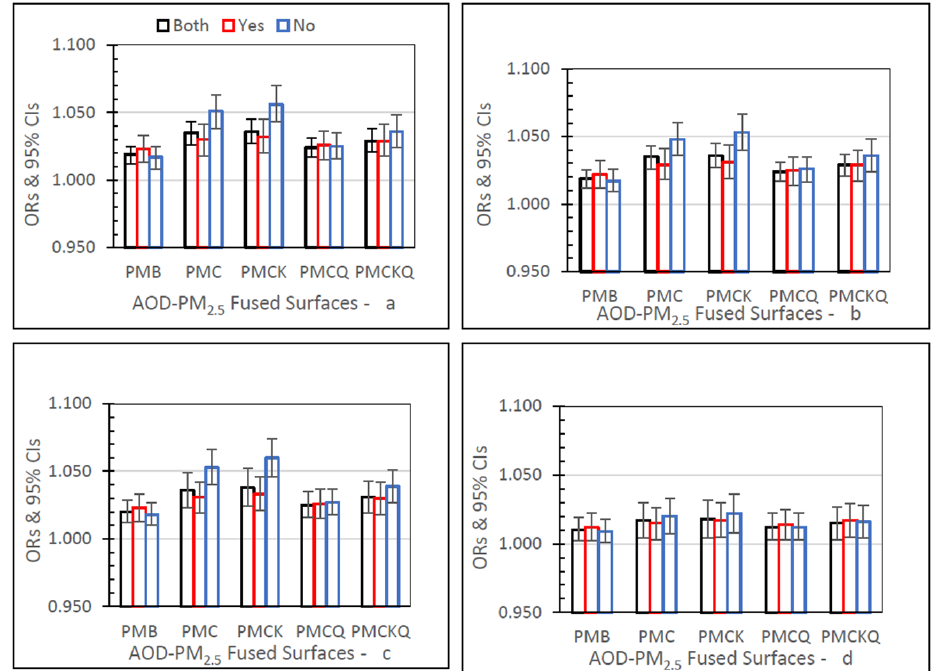
Figure 5. IP HF ORs (95% CIs) for the four AOD-PM 2.5 and baseline PMB fused surfaces, in all grids (Both), and in grids with (Yes) and without (No) air monitors, and in separate panels for lag grids 0 ( a ), 1 ( b ), 01 ( c ), and 04 ( d ).